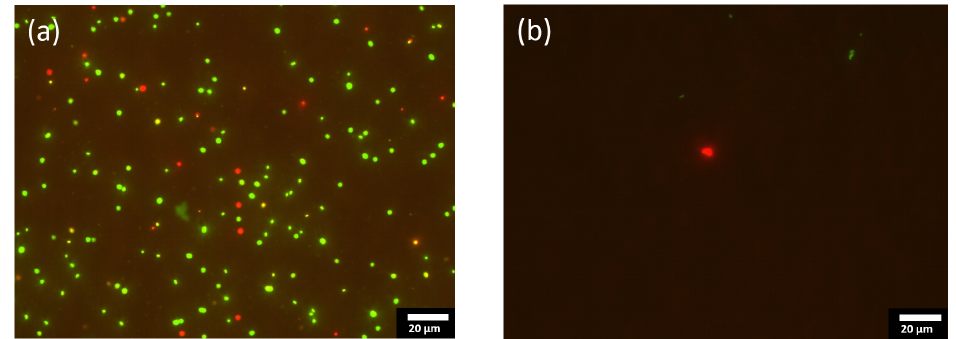
Figure 5. Fluorescent optical micrographs of the stainless steel substrate [SS] ( a ), and [Ag(22%)] ( b ), with bacterial species, S. aureus . These 2 pictures illustrate the results obtained by using the Live/Dead BacLight Bacterial Viability Kit. [SS] = stainless steel coupons (CTRL); [Ag(22%)] = the carbon matrix containing 22% of Ag in the bulk and 24% of Ag at the